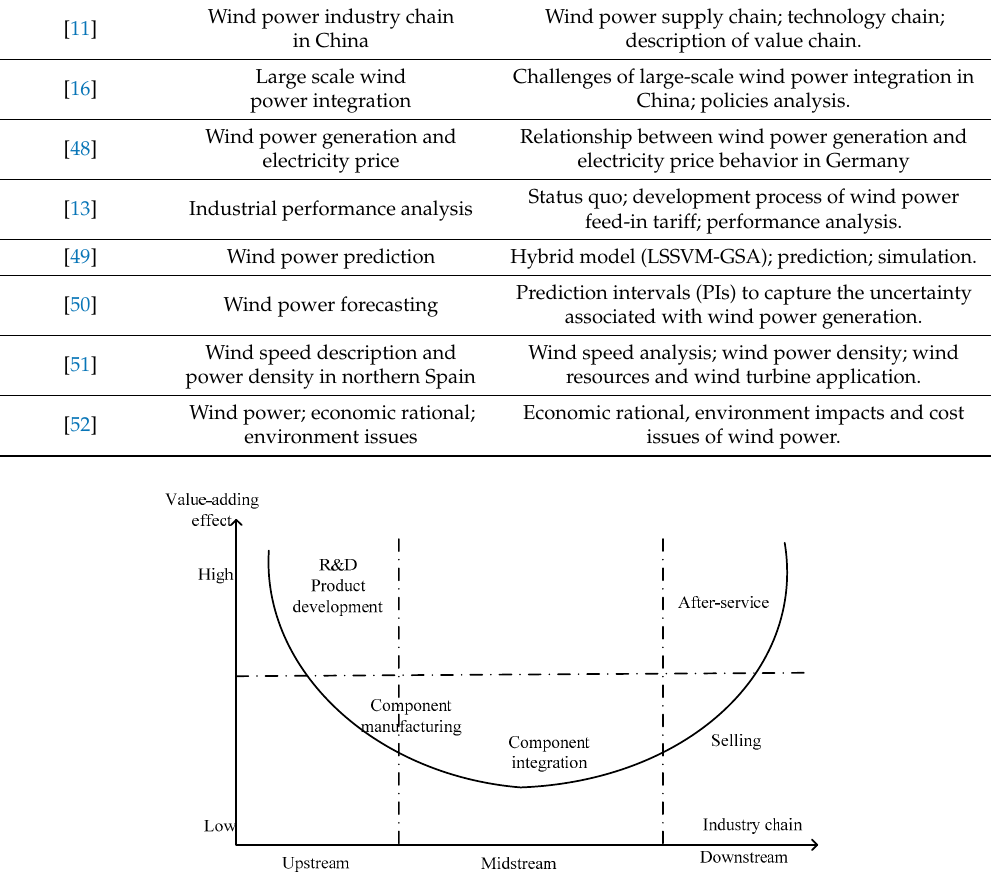
Figure 3. Smiling Curve of wind power industry.